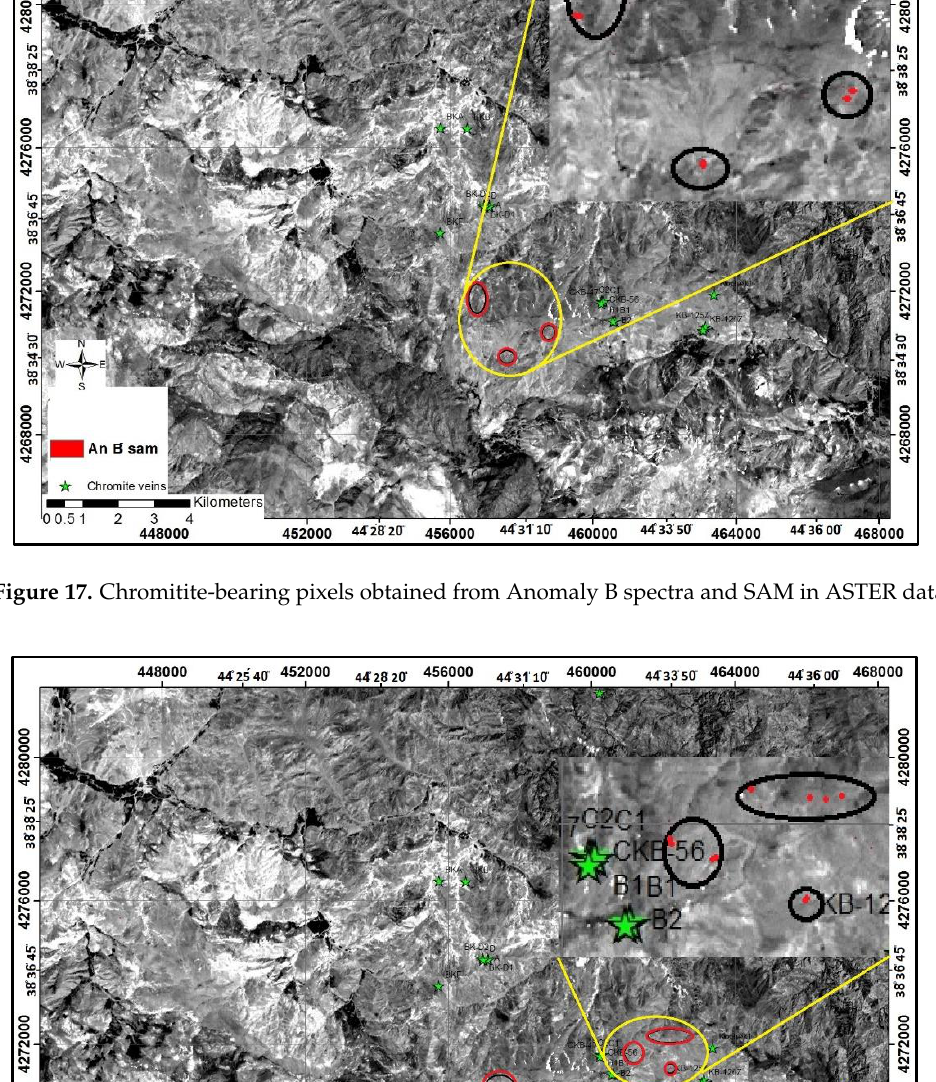
Figure 16. Reflectance spectra of harzburgite exposed at the Khoy ophiolite zone: spectra resampled to ASTER VNIR–SWIR band passes.